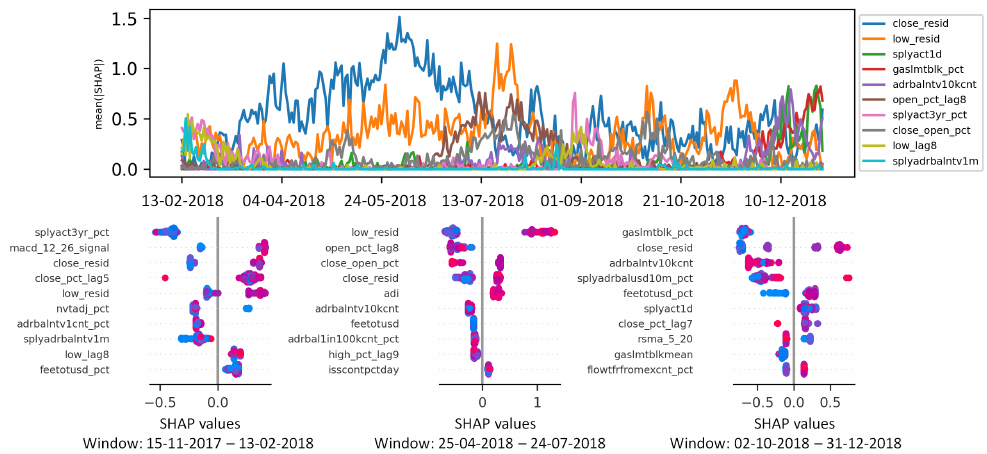
Figure 11. Interactive dashboard snapshot. Downtrend class. ETHUSD. Sliding training window size W =